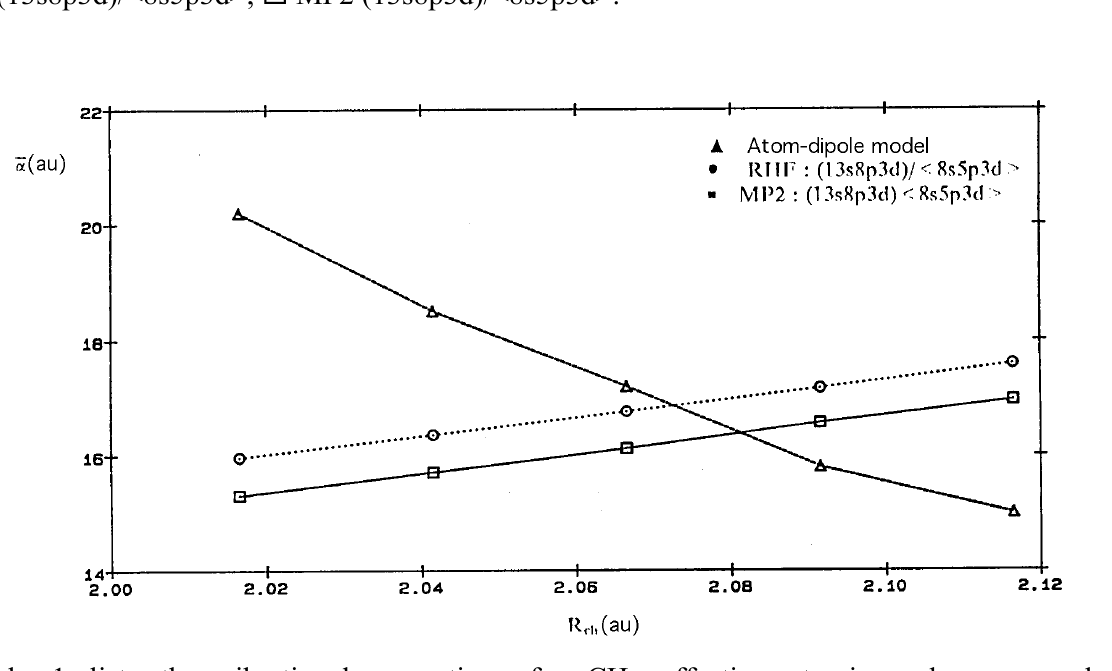
Figure 2. CH gradient of mean dipolar polarizability: ∆ atom-dipole model,  4